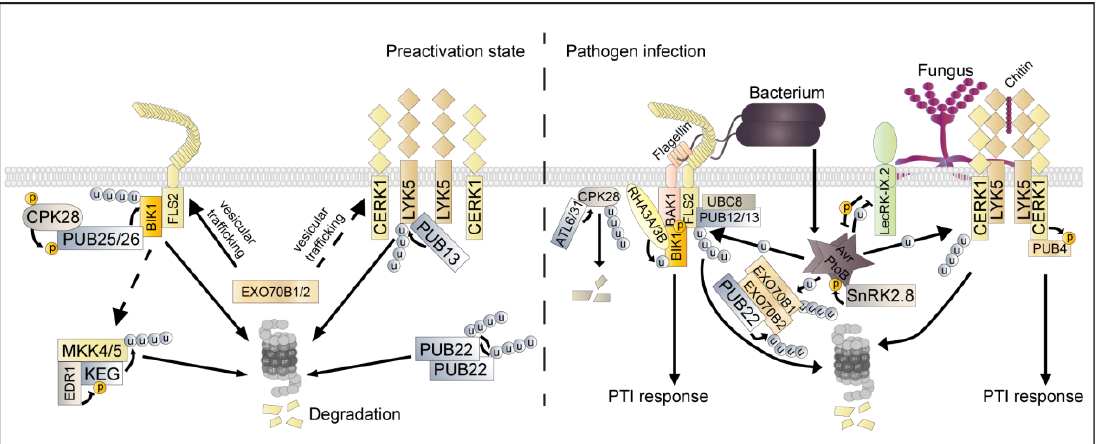
Figure 1. Ubiquitination regulation of PRR receptorsome-mediated signaling in Arabidopsis. In the resting state, exocyst subunits EXO70B1/2 regulate trafficking of the bacterial flagellin receptor FLS2 to the plasma membrane (PM). FLS2 associates with non-activated RLCK BIK1 subjected to polyubiquitination regulation by the E3 ligases PUB25/26. CPK28 phosphorylates PUB25/26 and enhances their enzymatic activities. In parallel, the protein abundance of the fungal chitin receptor LYK5 is also regulated by PUB13. The Raf-like MAPKKK family member EDR1 associates with and negatively affects KEG phosphorylation and self-ubiquitination, thereby enhancing MKK4/5 ubiq- uitination mediated by KEG. In addition, another E3 ligase, PUB22, undergoes degradation by autoubiquitination in a resting state. Upon flagellin perception by its cognate PRR FLS2, BAK1 phos- phorylates PUB12/13, which promotes PUB12/13-targeting-activated FLS2, leading to polyubiquiti- nation and degradation. E2 UBC8 partners with PUB13 and mediates FLS2 polyubiquitination. In contrast, chitin induces the dissociation of PUB13 and LYK5, thus reducing LYK5 polyubiquitina- tion and promoting LYK5 protein accumulation. PUB4 is phosphorylated by CERK1 and positively regulates chitin signaling. Unlike the polyubiquitination of BIK1 in a resting state, flg22-induced BIK1 activation requires E3 ligase RH3A/3B-mediated monoubiquitination. In addition, E3 ligases ATL31/6 positively regulate BIK1-mediated immunity by targeting CPK28 for ubiquitination and relief of the CPK28-mediated negative regulation of BIK1. Additionally, PUB22 is stabilized upon flg22 perception by inhibiting the autoubiquitination activity and oligomerization of flg22, which dampens the immune responses by promoting the ubiquitination of EXO70B2 and its degradation via the 26 S proteasome. Bacteria-delivered AvrPtoB ubiquitinates EXO70B1, leading to degradation and thereby suppressing immune responses. In addition, AvrPtoB targets multiple PRRs, including FLS2, CERK1, and LecRK-IX.2, for ubiquitination, thereby suppressing the response of PTI. In turn, PTI activation facilitates LecRK-IX.2 to phosphorylate AvrPtoB, which disrupts the self-association and compromises the virulence of AvrPtoB.